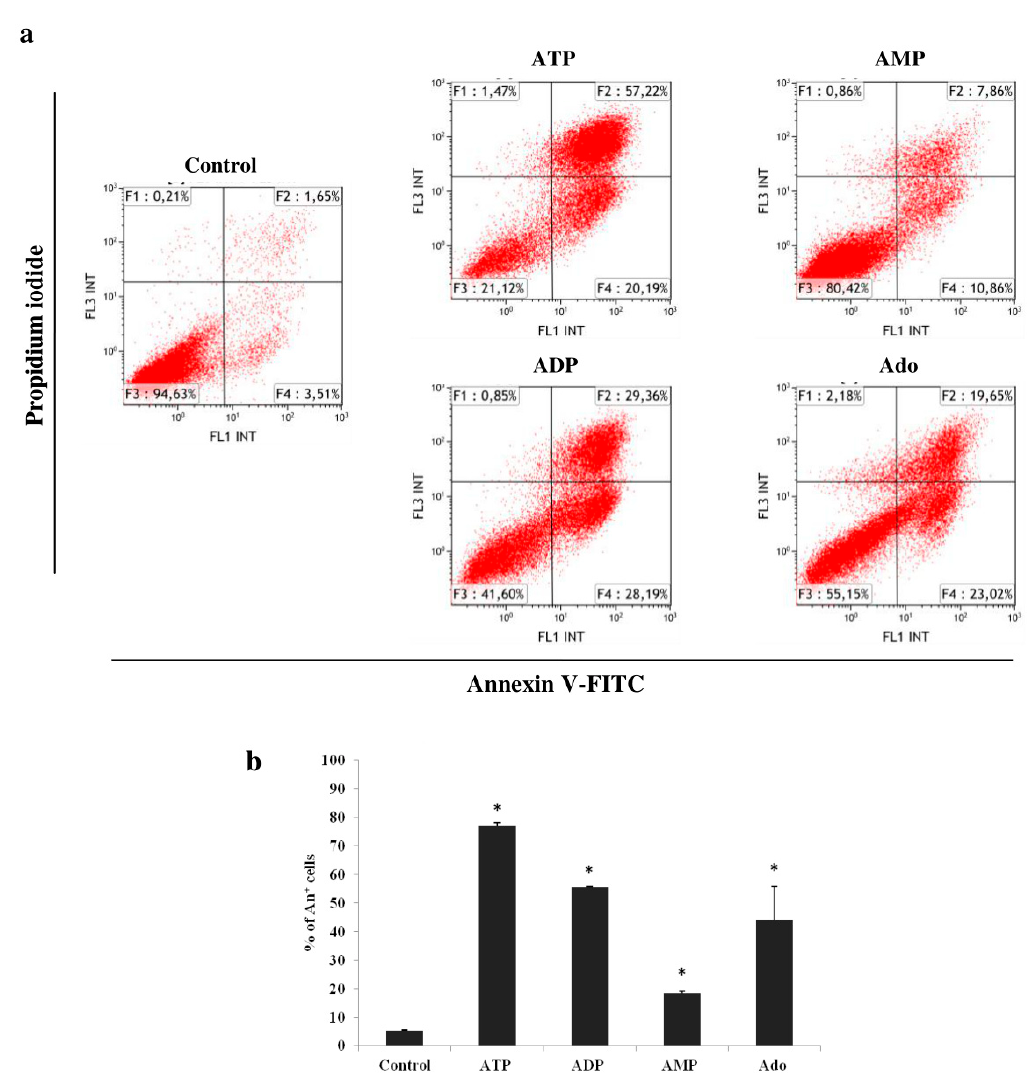
Figure 3. Effects of adenine nucleotides and adenosine (Ado) on apoptosis in THP-1 cells. ( a ) Representative flow cytometric analysis of THP-1 cells stained with annexin V-FITC and propidium iodide after 72 h of incubation with 1000 µM of adenine nucleotides or adenosine. ( b ) Percentage of apoptotic cells (Annexin V + , An + ), induced by ATP, ADP, AMP and adenosine. Data are presented as the mean ± SD of three different experiments. * p < 0.05 compared with the unstimulated control cell culture.